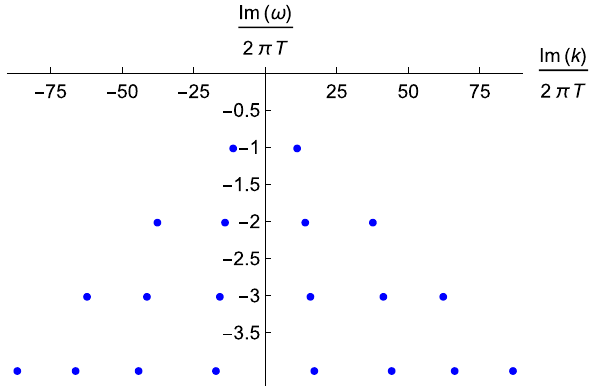
Fig. 3 The pole-skipping points in acoustic black holes from general relativistic fluids near acoustic horizon r h , where r h = 6